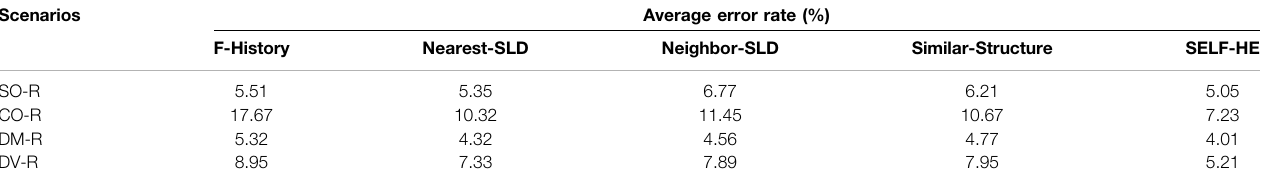
TABLE 4 | Comparison of the methods under different